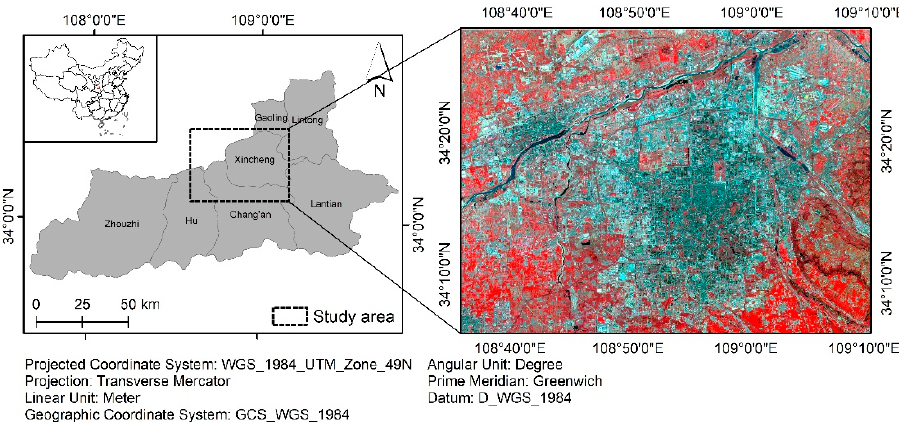
Figure 1. Geographic location of the study area. The satellite image is false color composite of Landsat